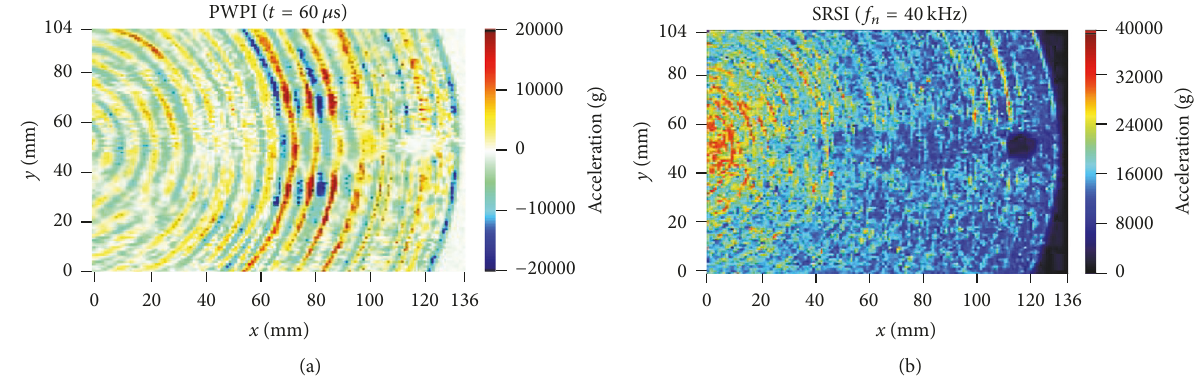
Figure 24: Pyroshock propagation evaluation on the disk type specimen; (a) PWPI at 60 𝜇 s. (b) SRSI at 40 kHz.